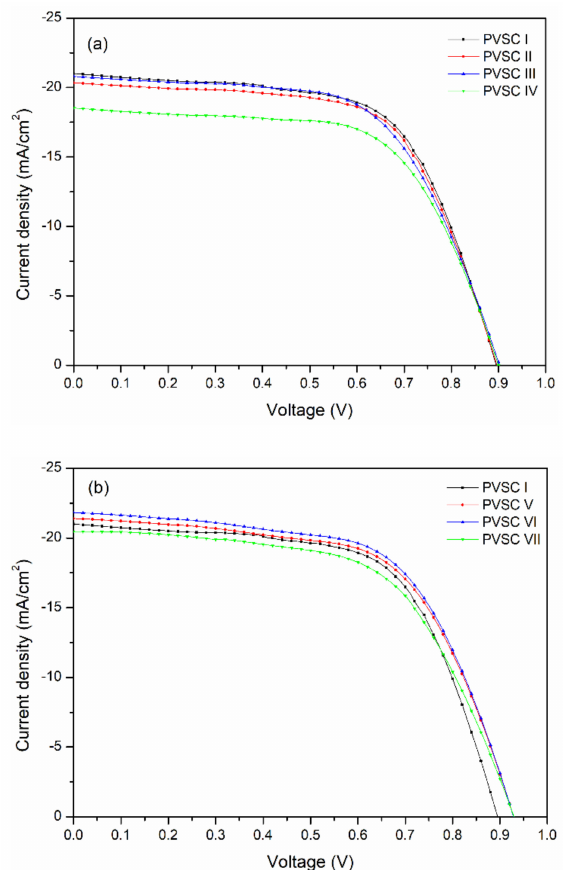
Figure 10. Current density–potential plots of PVSCs incorporating BCP, BCP/PMMA, and BCP/PVP films (( a ) BCP (PVSC I), BCP/PMMA (PVSC II-IV); ( b ) BCP/PVP (PVSC V-VII)), illuminated under AM 1.5G light at 100 mW cm − 2